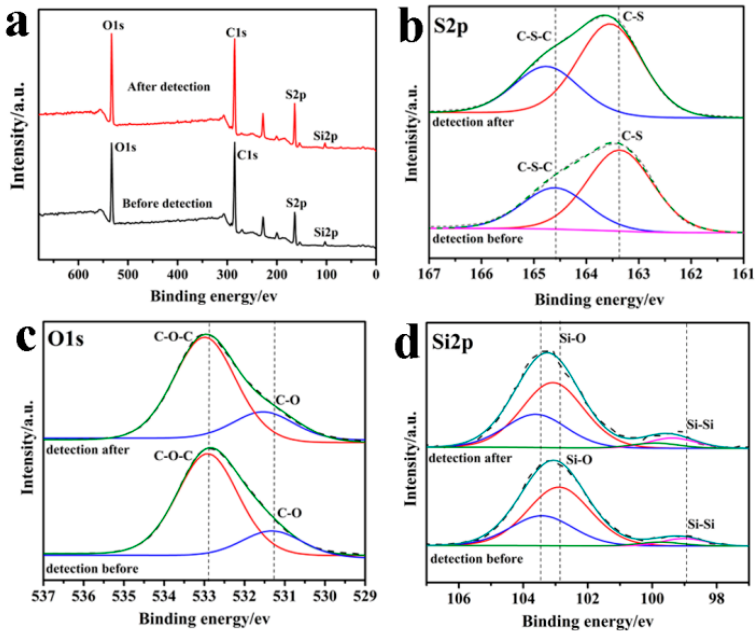
Figure 10. X-ray photoelectron spectroscopy (XPS) spectrum of: ( a ) PProDOT(MeSH) 2 @Si before and after detection of Cd(II), Pb(II), and Hg(II); high-resolution scans of ( b ) S2p, ( c ) O1s, and ( d ) Si2p.